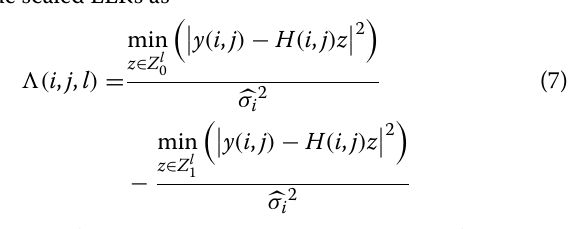
average noise variance over entire U sub does not provide local noise variance (LNV) information across the